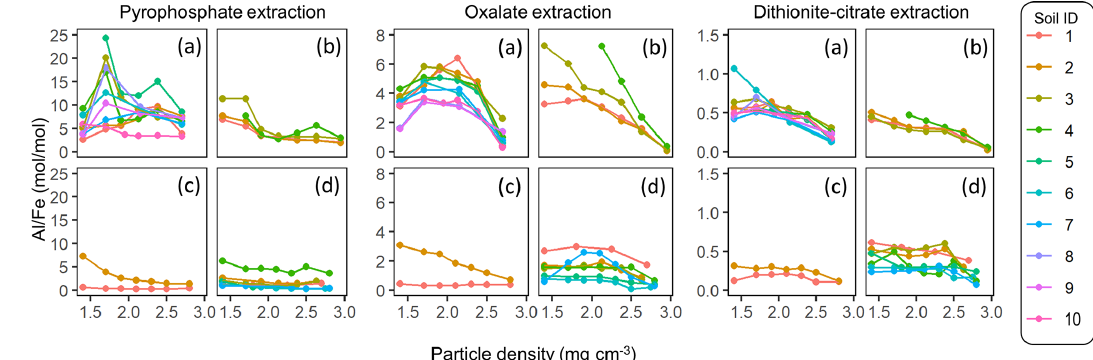
Figure A5. Molar Al-to-Fe ratio of each extractable phase from each density fraction along the density gradient. The ratio was shown for initial pyrophosphate (left four plots) and subsequent acid oxalate (middle four plots), and final dithionite–citrate extractions (right four plots) were shown for allophanic Andisols (a) , non-allophanic Andisols (b) , Spodosols (c) , and crystalline mineralogy group (d) . Each symbol represents the individual soil sample ID in Table 1.